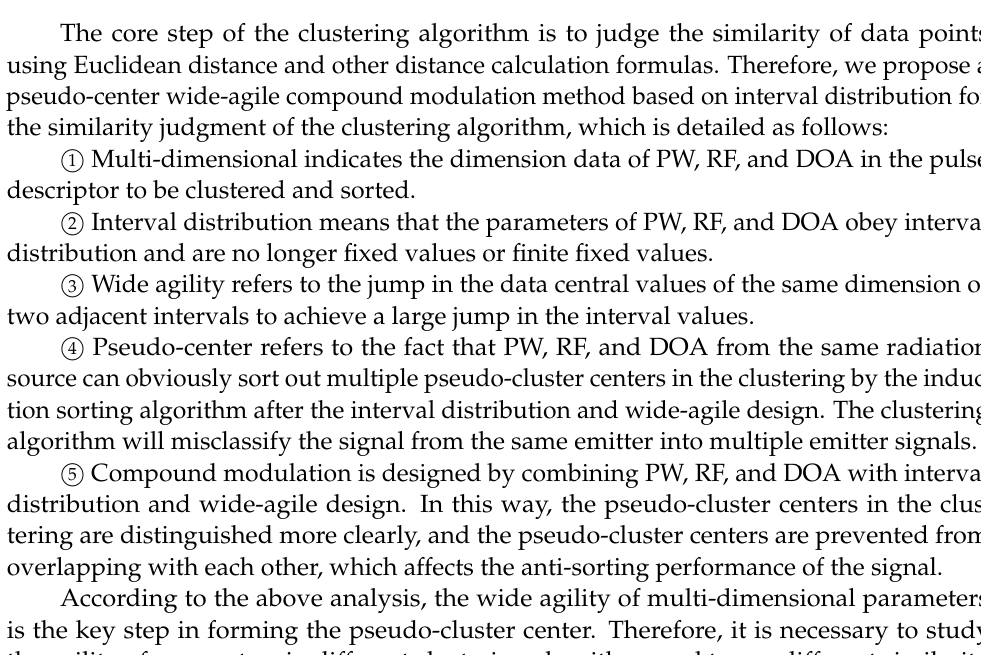
Figure 3. The derivation logic diagram in this paper.